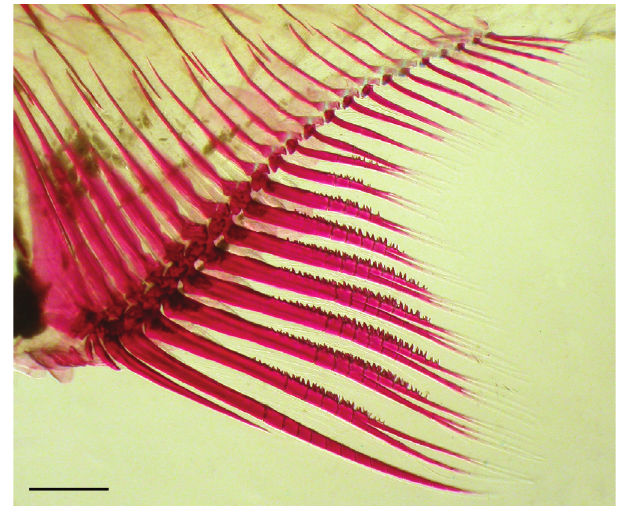
Fig. 4. Anal fin of a mature male of the Serrapinnus potiguar , paratype, UFRGS 9216, 27.4 mm SL, showing hypertrophied anal-fin rays and hooks shape and distribution. Lateral view, anterior to the left. Scale bar = 1